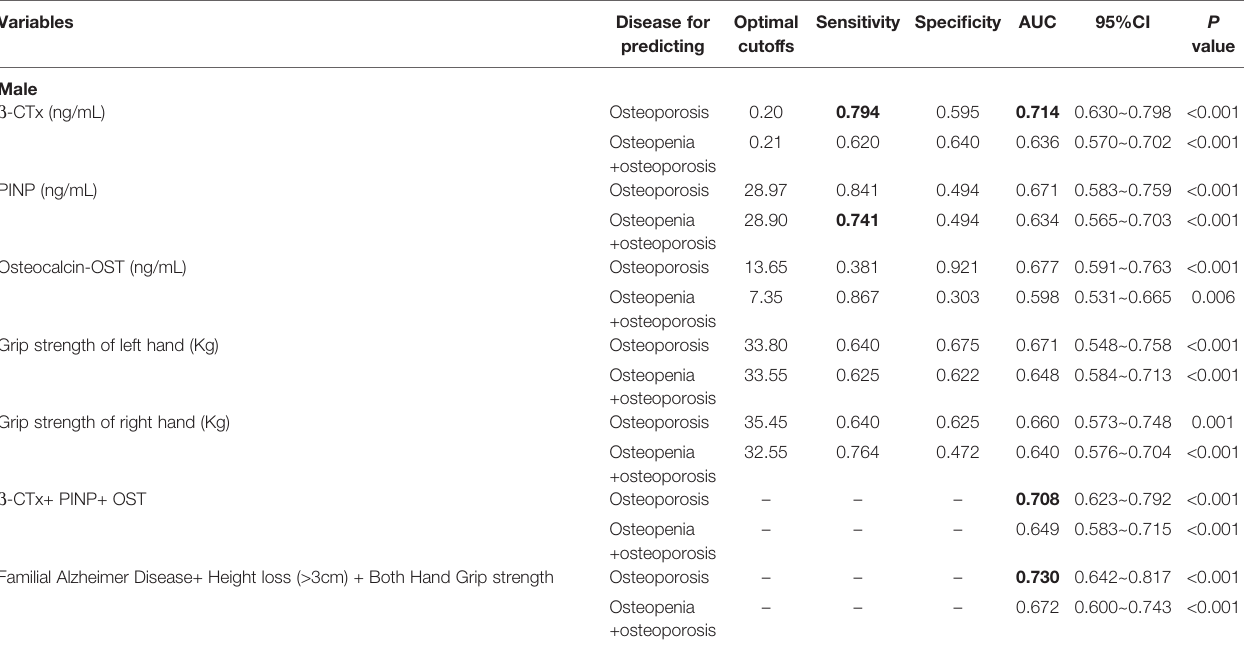
TABLE 6 | Multivariate analysis of relevant risk factors for osteoporosis.